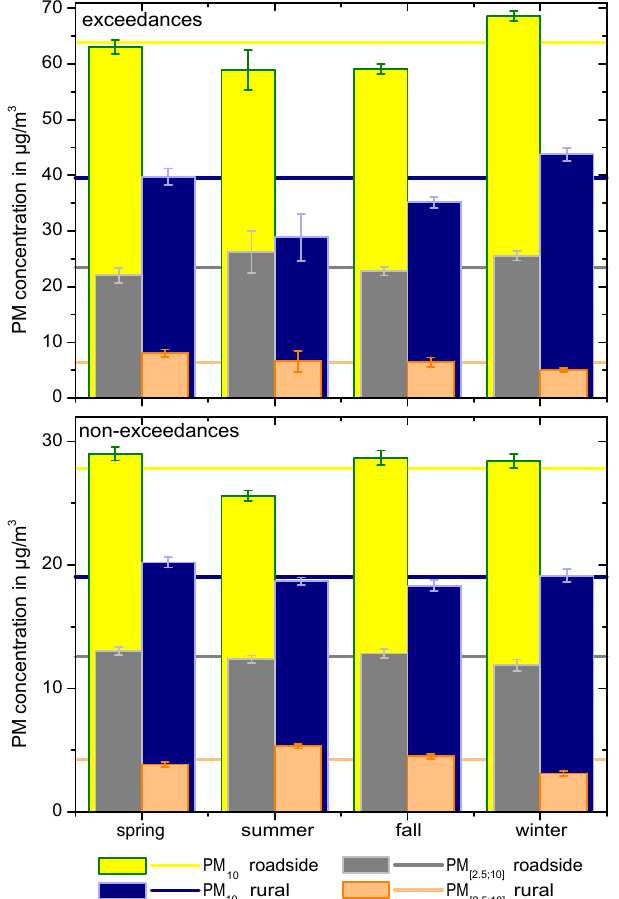
Fig. 6. Seasonal dependence of PM 10 and PM [ 2 . 5 ; 10 ] at roadside and in the rural background. The display distinguishes between exceedance days (upper graph) and non-exceedance days (lower graph). Horizontal lines indicate annual average values. The